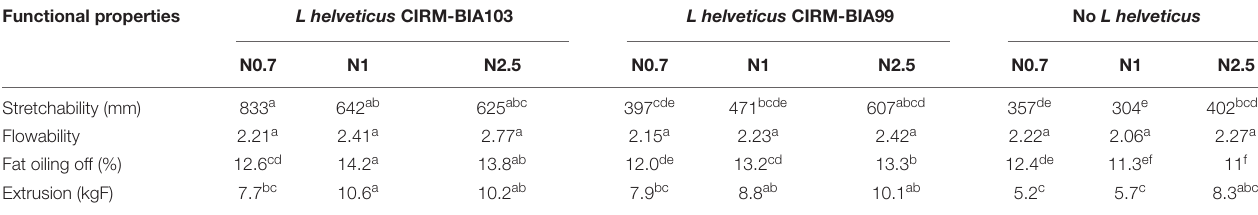
TABLE 4 | Techno-functional properties of Swiss cheeses manufactured using different Lactobacillus helveticus strains and NaCl concentrations. Functional